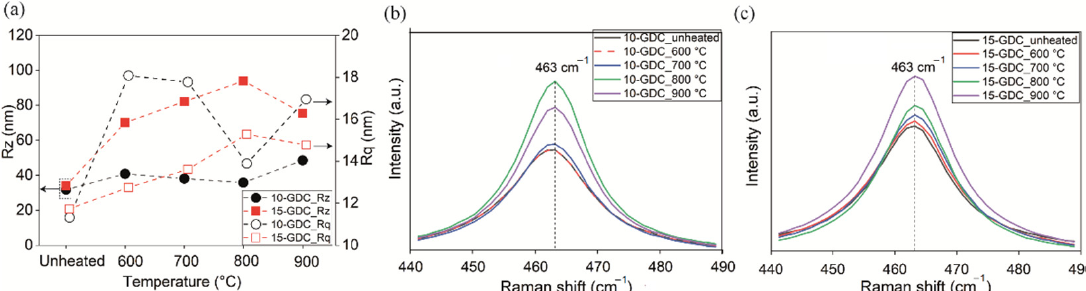
Figure 7. ( a ) Surface roughness parameters calculated from the AFM images of 10-GDC and 15-GDC thin films: as-evaporated, and after additional thermal treatment, where R q is the root mean square and R z is the average height. Raman spectra of ( b ) 10-GDC and ( c ) 15-GDC thin films: unheated, and after additional thermal treatment at 600, 700, 800, and 900 °C for 1 h.